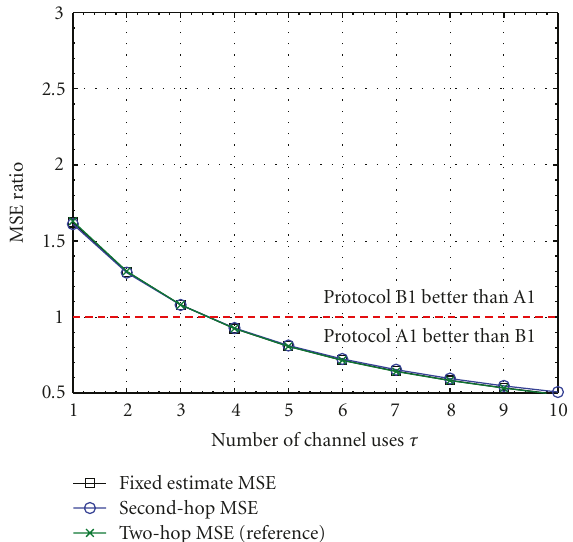
Figure 5: MSE ratios (see page 23) versus τ for N R = 10, SNR est = = 10 − 2 20dB, and σ 2 pn